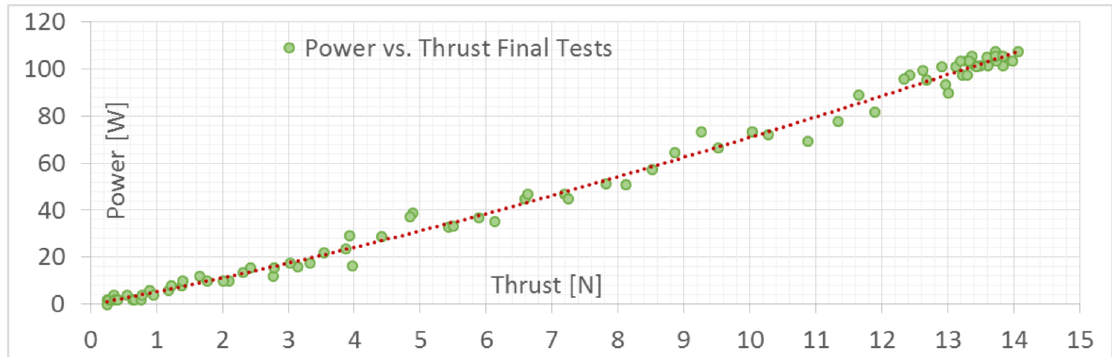
Figure 19. Results of bollard pull thrust tests: power vs.